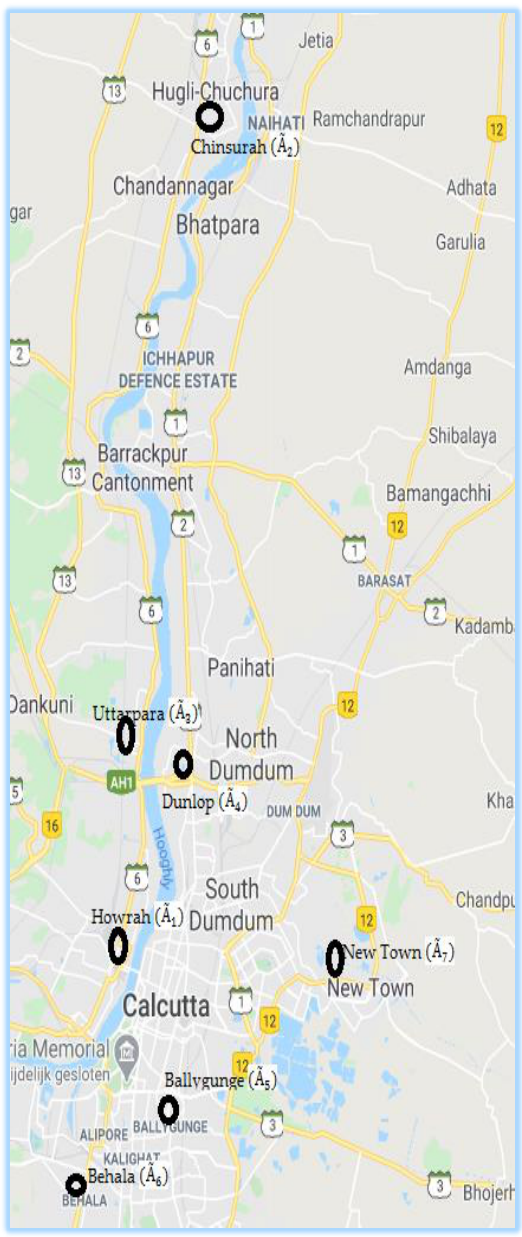
Figure 4. The symbol in Google maps represents different site locations considered in and around the city of Kolkata(Calcutta) for this study.